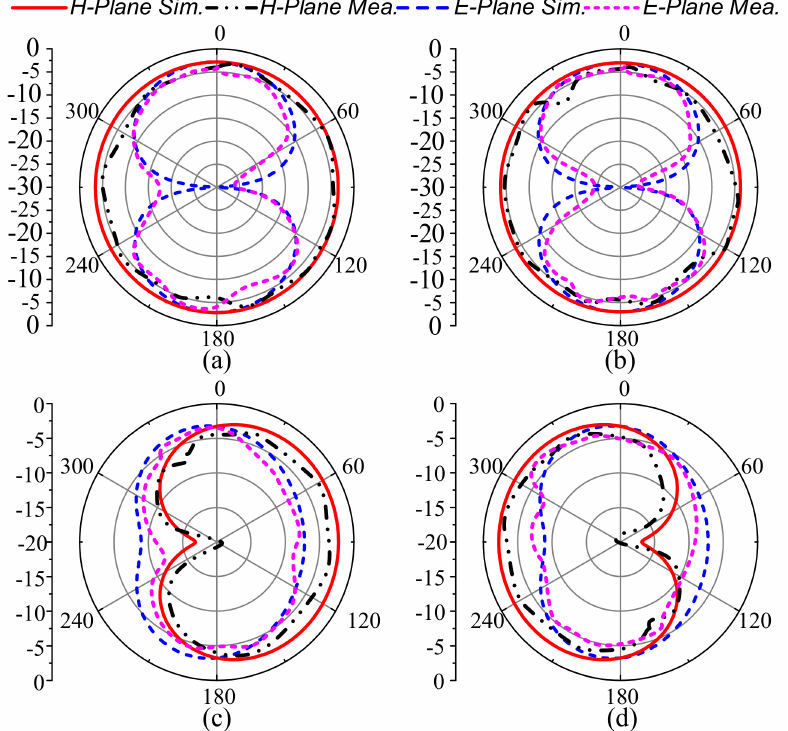
Figure 11. Comparison among simulated and measured radiation patterns ( a ) 2.1 GHz [case-00];